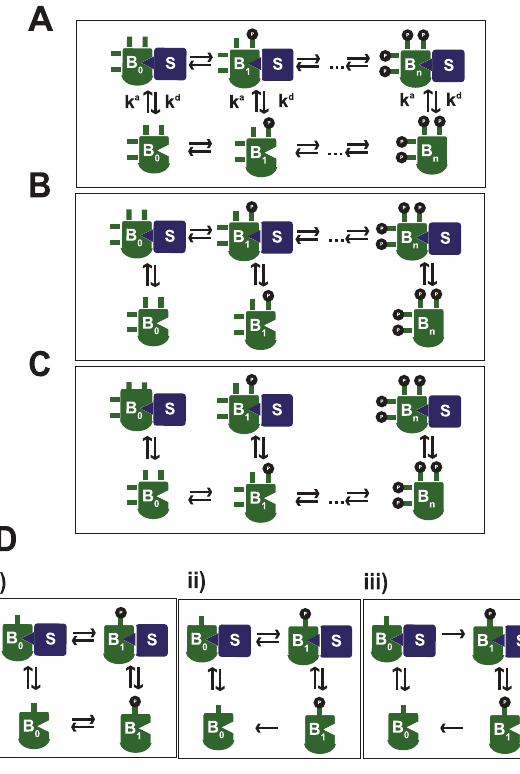
Figure 2. Network topologies that only support monostability under the linear model (LR-S). A) Phosphorylation and dephos- phorylation take place equally on- and off-scaffold, and the scaffold binding parameters k a (as well as k d ) are equal across all phosphoforms B i . B) Phosphorylation and dephosphorylation happen only on scaffold- bound substrates. C) Phosphorylation and dephosphorylation take place only on scaffold-unbound substrates. D) Single phosphorylation site, n ~ 1 . Di): phosphorylation and dephosphorylation both on-